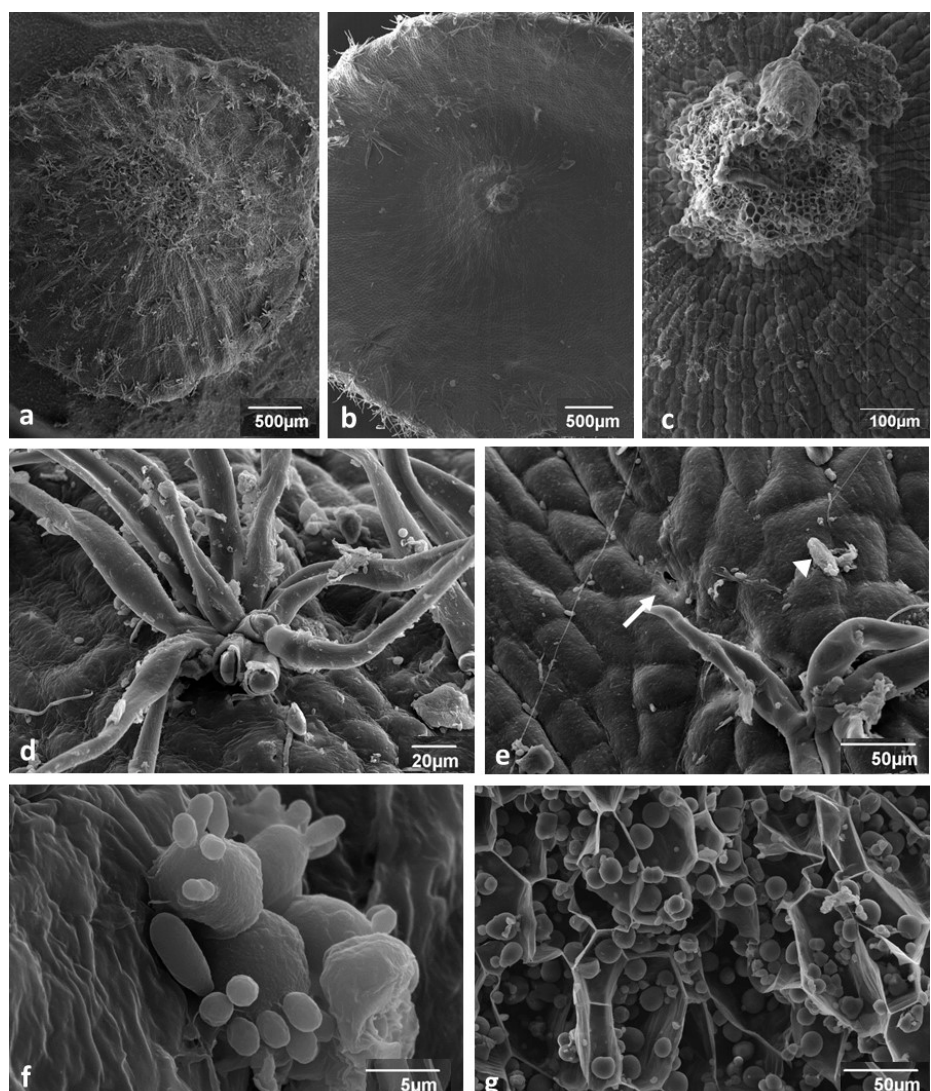
Figure 2. Young spangle gall collected at the end of July (SEM images). ( a ) Outer side with numerous tufted (stellate) hairs. ( b ) Inner side; in the centre is a broken stalk (peduncle) that attaches the gall to the abaxial side of the leaf. ( c ) Detail of a broken stalk showing radial files of leaf epidermal cells. ( d ) Cluster of tufted hairs. Broken ends show extremely thick walls almost completely filling the cell lumen. ( e ) Small stomata-like opening (an arrow) on the outer surface of a gall. A spore of an unknown organism (an arrowhead) and a silk thread left by an insect or arachnid are also visible. ( f ) Yeastlike organism on abaxial surface of a gall. ( g ) Thin-walled gall parenchyma cells with abundant starch grains.